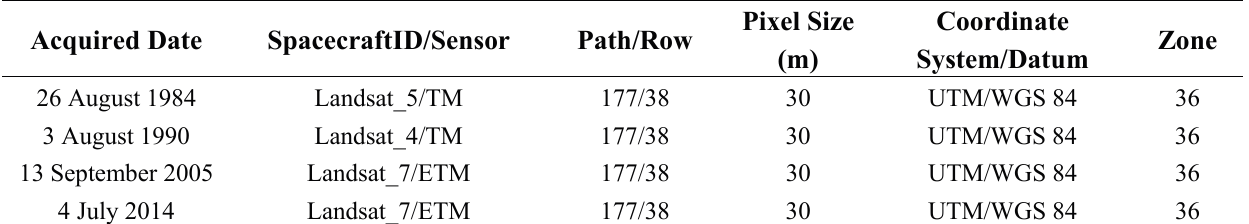
Table 1. Details of the satellite images used in this